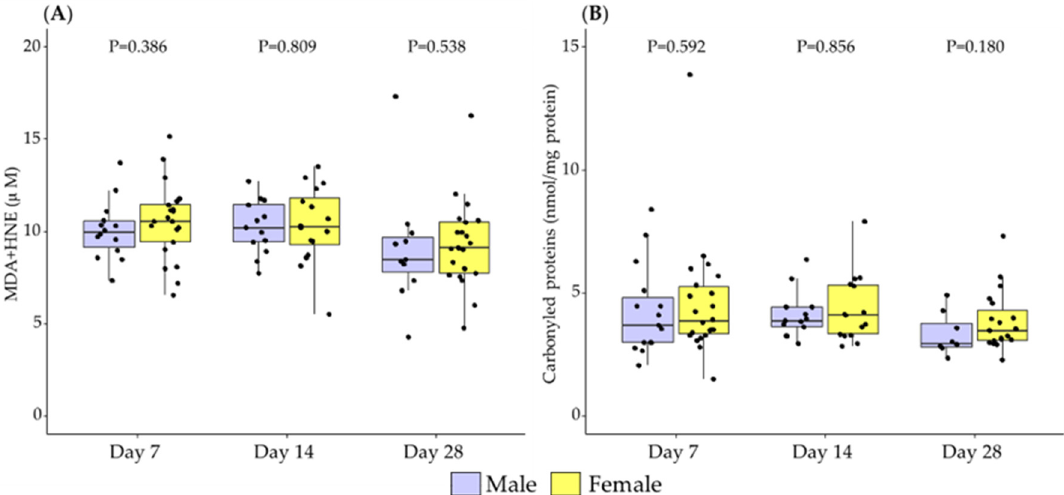
Figure 4. The evolution of breast milk lipid peroxidation ( A ) and protein oxidation ( B ) during the first month of lactation according to the sex of the newborn. Data show median and interquartile range [Q1; Q3]. Neonatal sex was compared according to the day of lactation using the Mann-Whitney U test and extracted p -Value ( p ) adjusted by Holm-Bonferroni multiple comparison methods was reported in the figure. MDA: malondialdehyde; HNE: 4-Hydroxy-Trans-2-Nonenal.